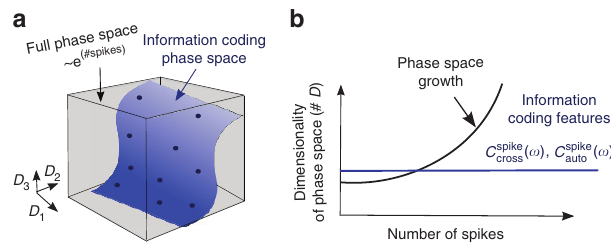
Figure 1 | Dimensionality of neural information coding. ( a ) Phase space spanned by possible spike time combinations (grey box) relative to the information coding subspace (blue area) for a given number of spikes. If the relevant features are known, only the lower dimensional subspace has to be sampled (black dots), to estimate the neural information content. ( b ) Phase space grows exponentially with increasing number of spikes, whereas the relevant coding features remain constant. In this study we argue that the information-relevant features are C spike and C spike , which we derive in auto ð o Þ cross ð o Þ equations (2) and